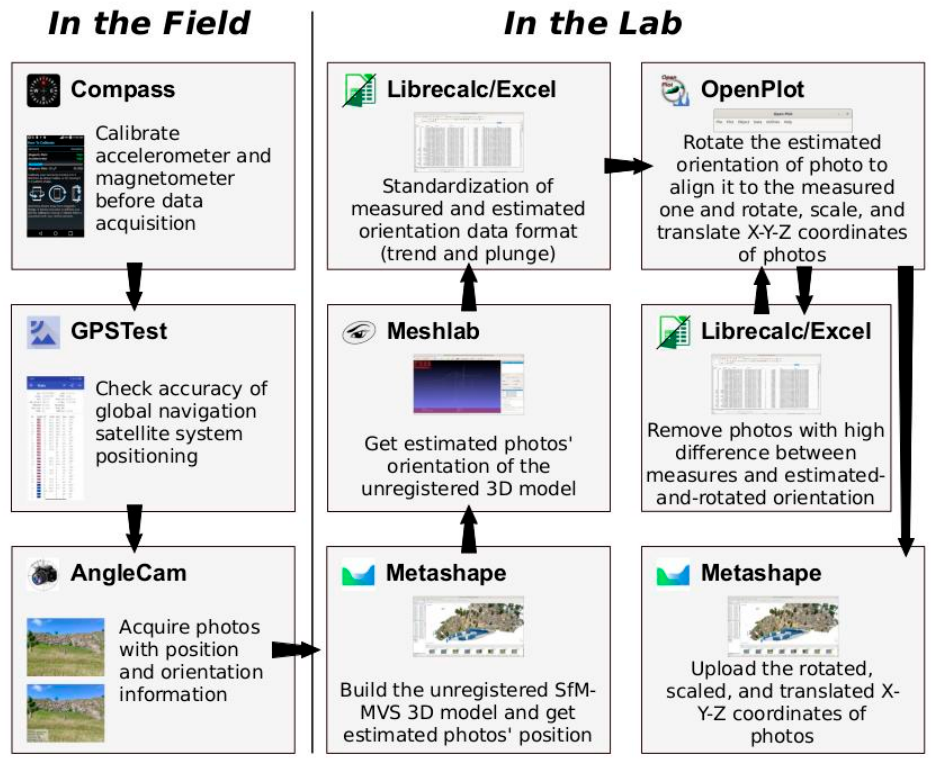
Figure 2. Workflow for SfM-MVS photogrammetric model production and registration from Figure2. WorkflowforSfM-MVSphotogrammetricmodelproductionandregistrationfromsmartphone sensors with the software packages and Android apps used in this